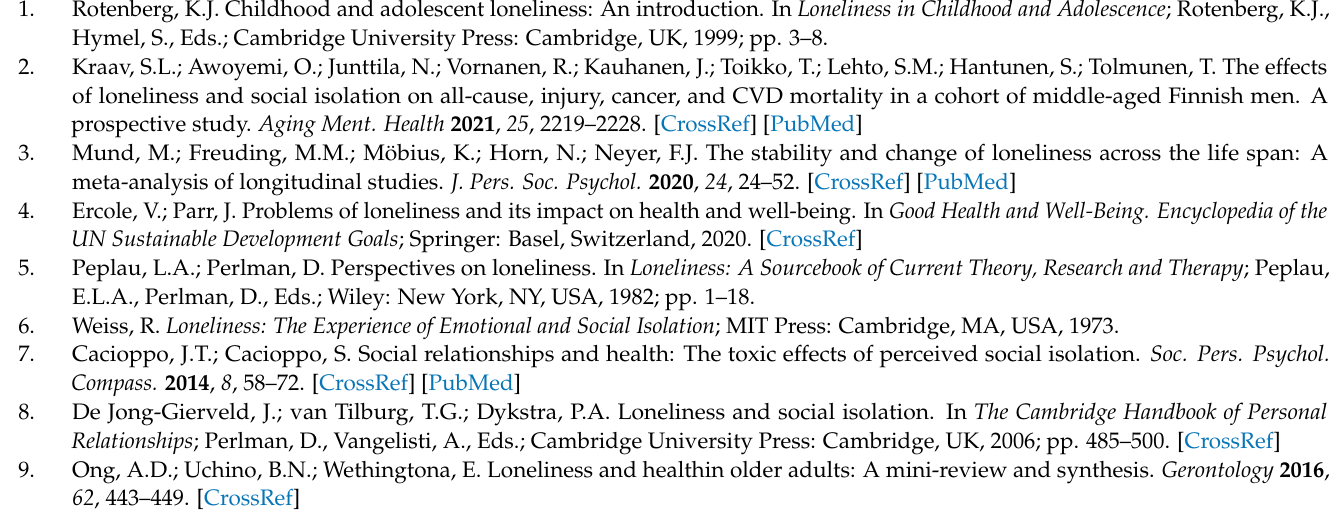
groups. Table S2. Comparison of means between groups in men. Table S3. Comparison of means between groups in women. Table S4. Logistic regression analysis SNPs and